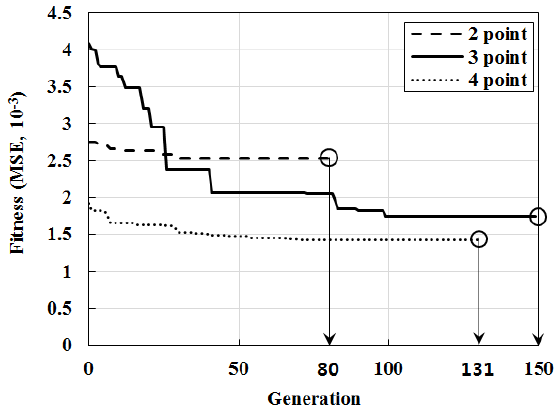
Figure 11. The best fitness value changes in generations by GA.